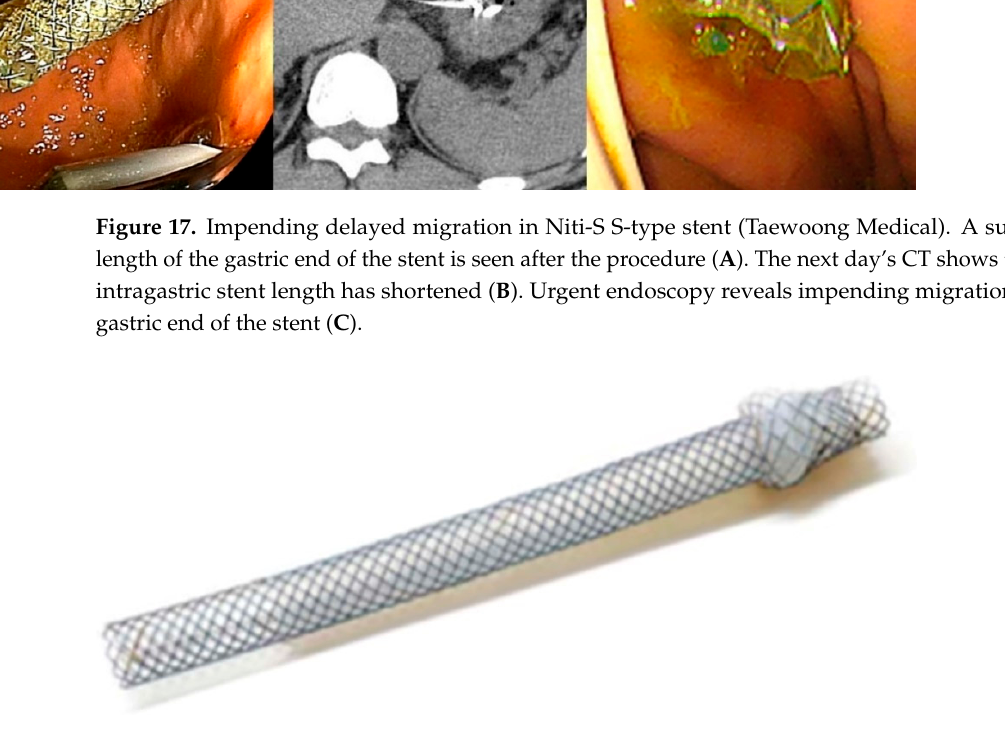
Figure 18. Spring Stopper Stent (Taewoong Medical), which has a spring-type stopper as an anti- migration system at the gastric end. (Courtesy of Taewoong Medical).